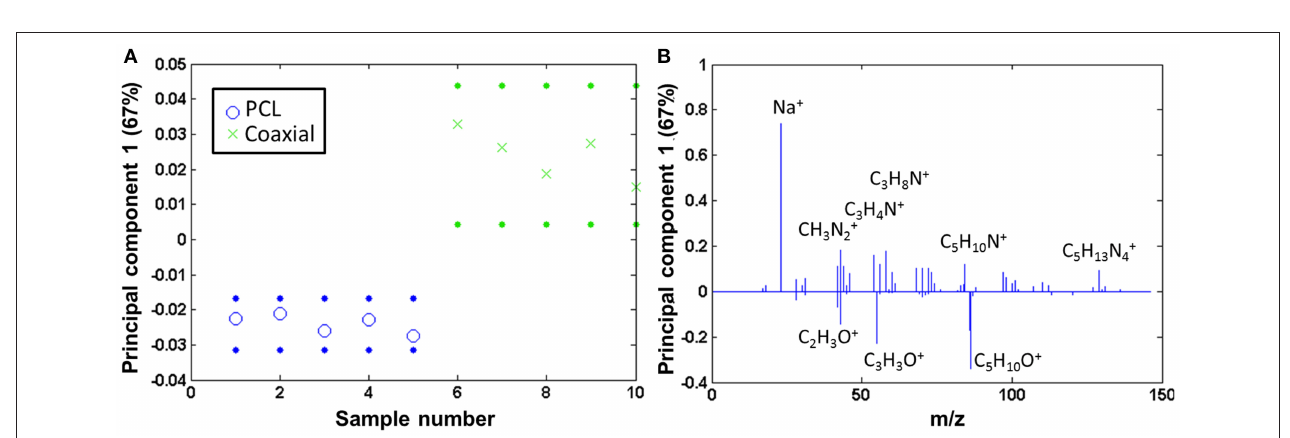
FIGURE 7 | PCA comparing the coaxial samples to bare PCL: (A) scores (with 95% confidence limits; dotted lines) and (B) corresponding